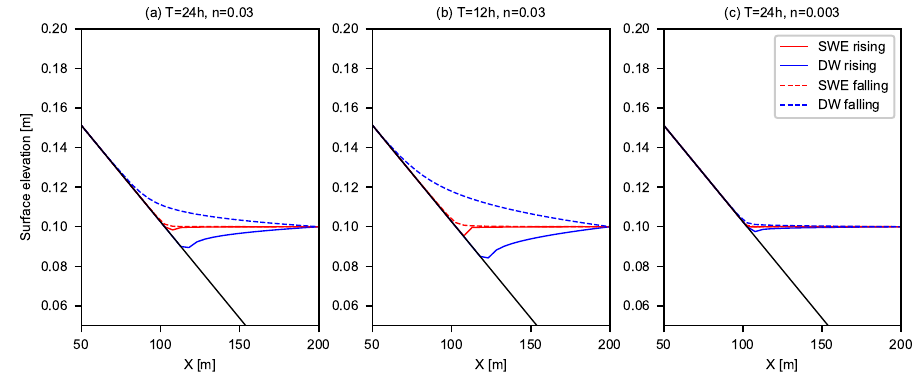
Figure 8. Surface profiles for a rising tide at t = 6 T tide and a falling tide at t = ( 6 + π ) T tide